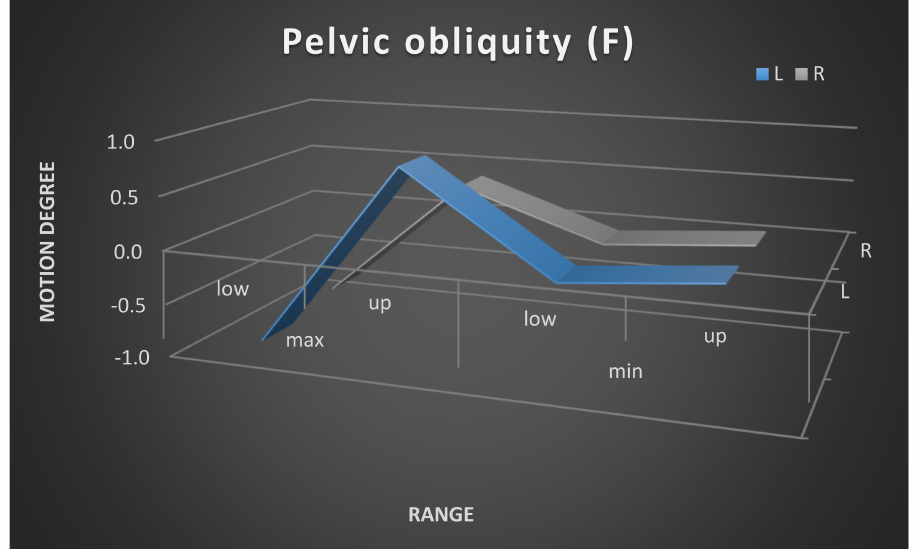
Figure 4. Pelvic obliquity maximum and minimum range of movement. Left and right side